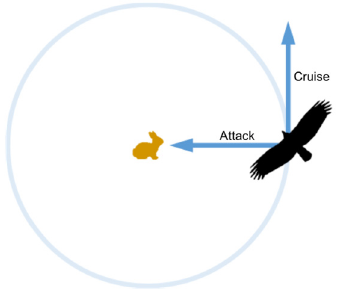
Figure 4. Hunting behavior of golden